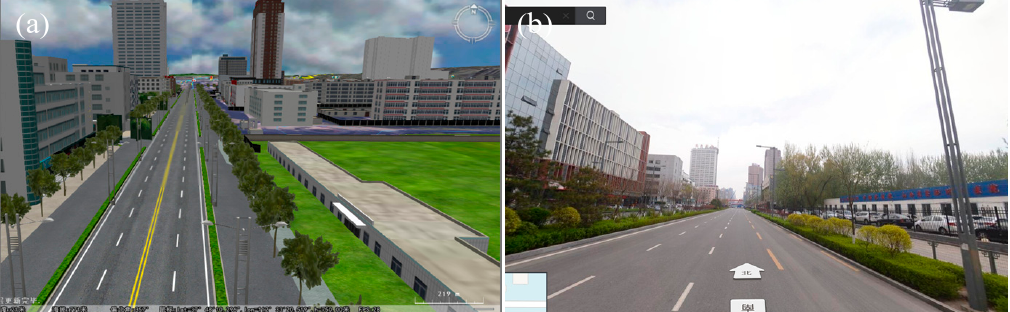
Figure 14. Road modeling effect comparison: ( a ) Our modeling effects; ( b ) real street view map.